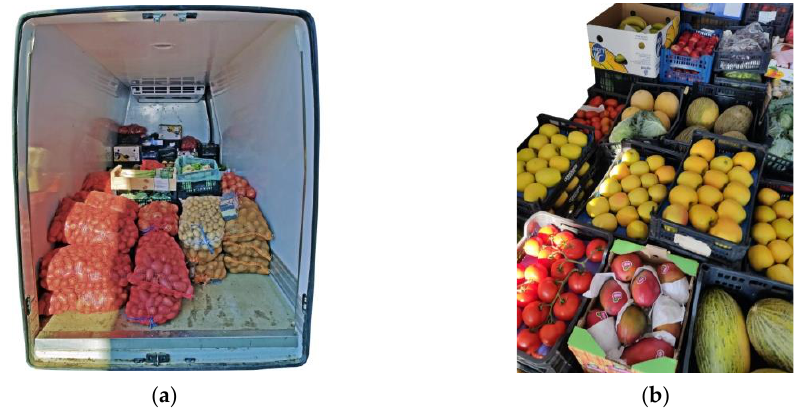
Figure 5. Final produce arrangement within the truck ( a ), and sample of the diversity of produce transported ( b ).